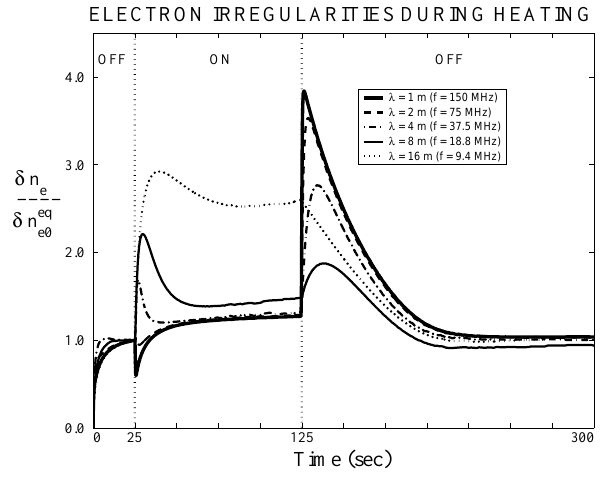
Fig. 1. The time evolution of electron irregularities during ra- diowave heating with varying irregularity wavelength (and radar frequency) utilizing the computational model. The heating is turned on at 25s and off at